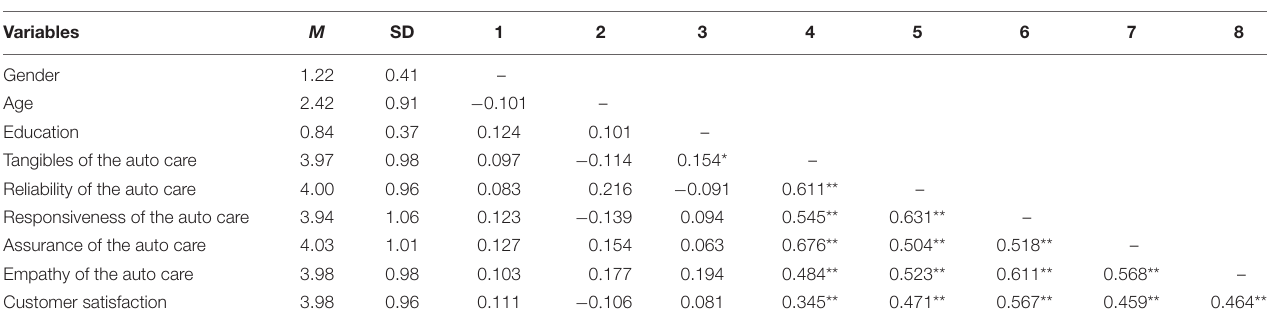
TABLE 4 | Descriptive statistics and